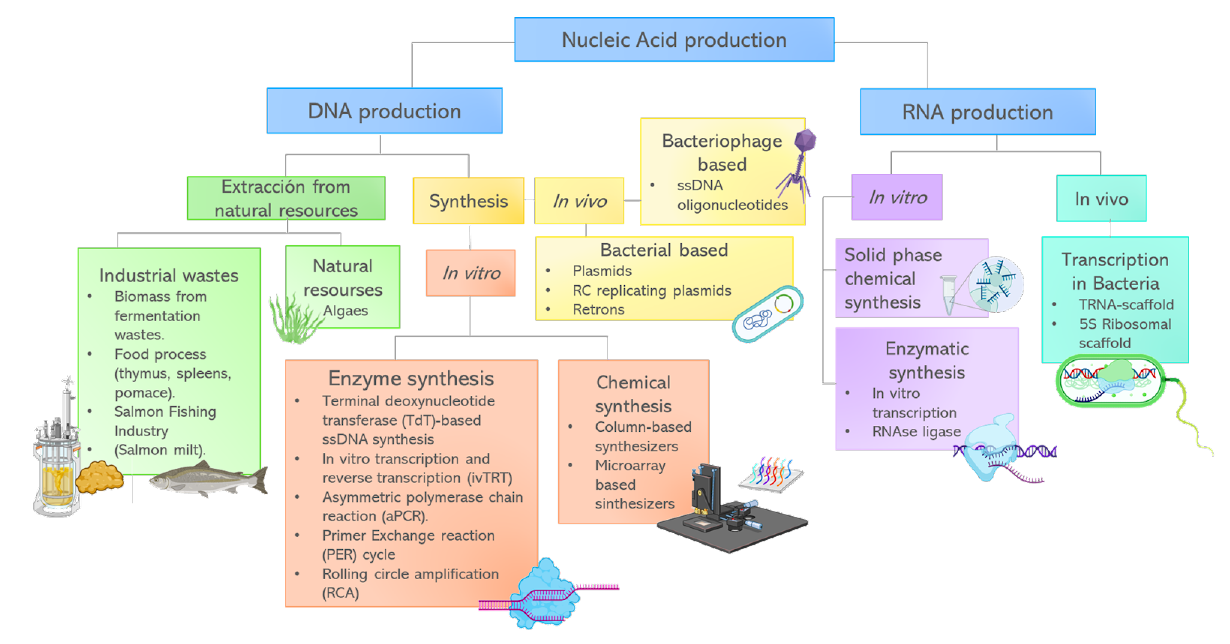
Figure 7. DNA and RNA sources from nature and methods of